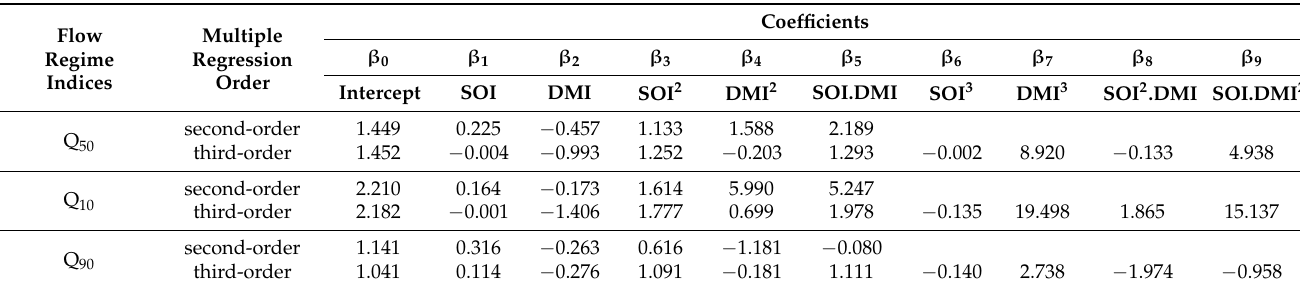
Table 4. Multiple regression (MR) model coefficients developed from a 6-month moving average dataset and lagged regression with climate indices lead streamflow indices by 6 months. To be used with the corresponding equations provided in the Section